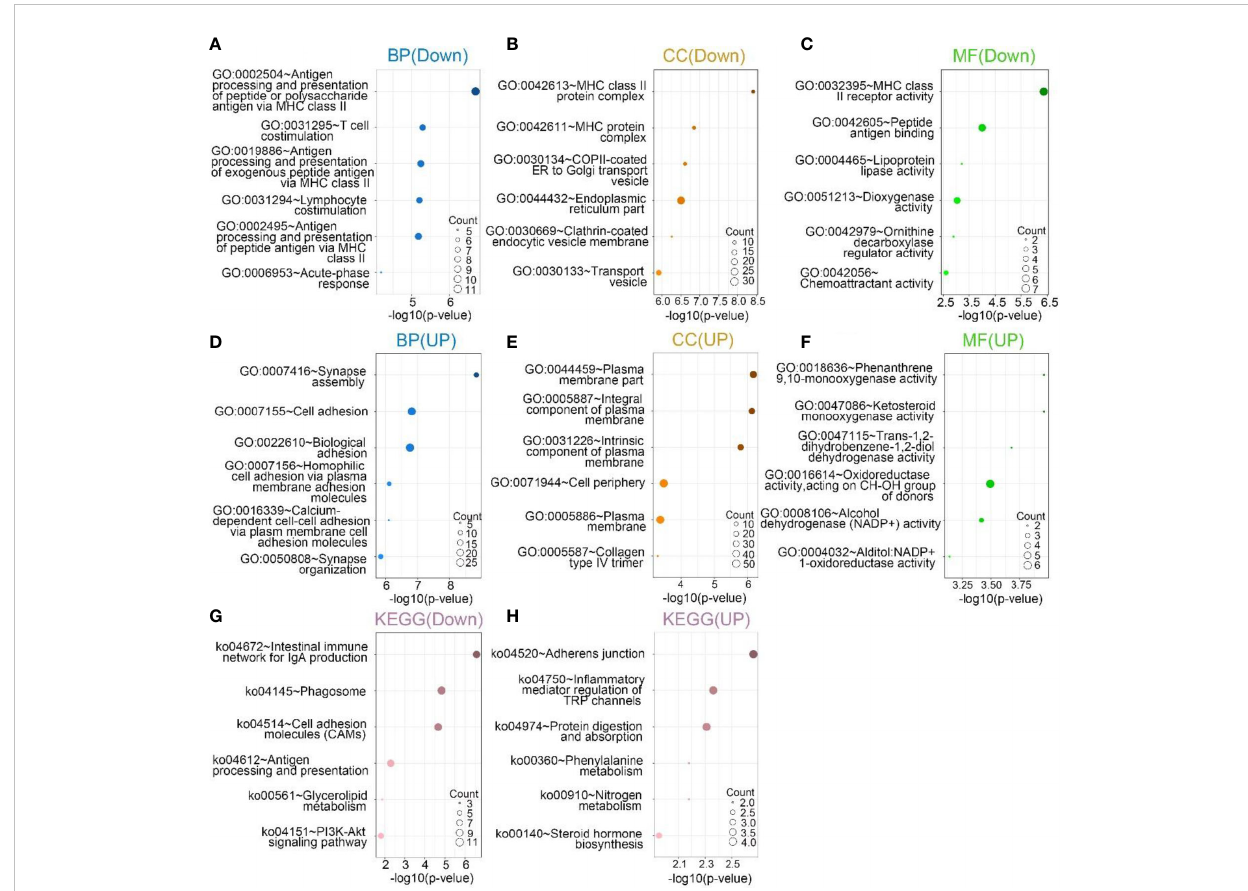
FIGURE 7 (A – C, G) In the sequencing downregulation group, the top 6 biological processes (BPs), cellular components (CCs), and molecular functions (MFs), Kyoto Encyclopedia of Genes and Genomes (KEGG) pathway analysis most related to SPON2. (D – F, H) In the sequencing upregulation group, the top 6 biological processes (BP), cellular components (CCs), and molecular functions (MFs), Kyoto Encyclopedia of Genes and Genomes (KEGG) pathway analysis most related to